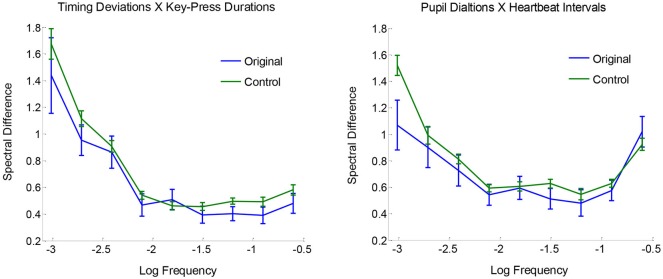
Mean spectral differences |log(Sf,a)− log(Sf,b)| plotted as a function of frequency, for originals and surrogate controls, with standard error bars.